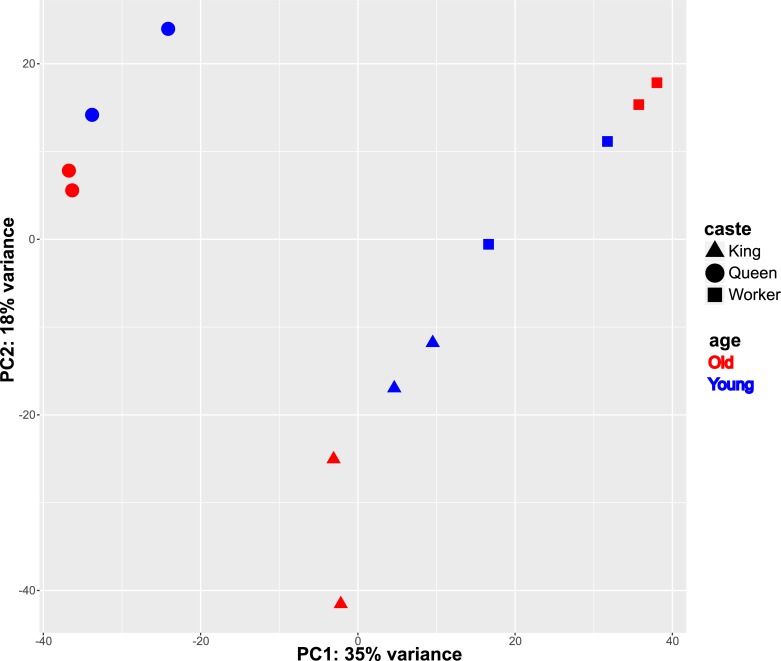
Principal component analysis of transcript count data.Principal component analysis of transcript count data with variance stabilizing transformation for two age classes of reproductives and workers.